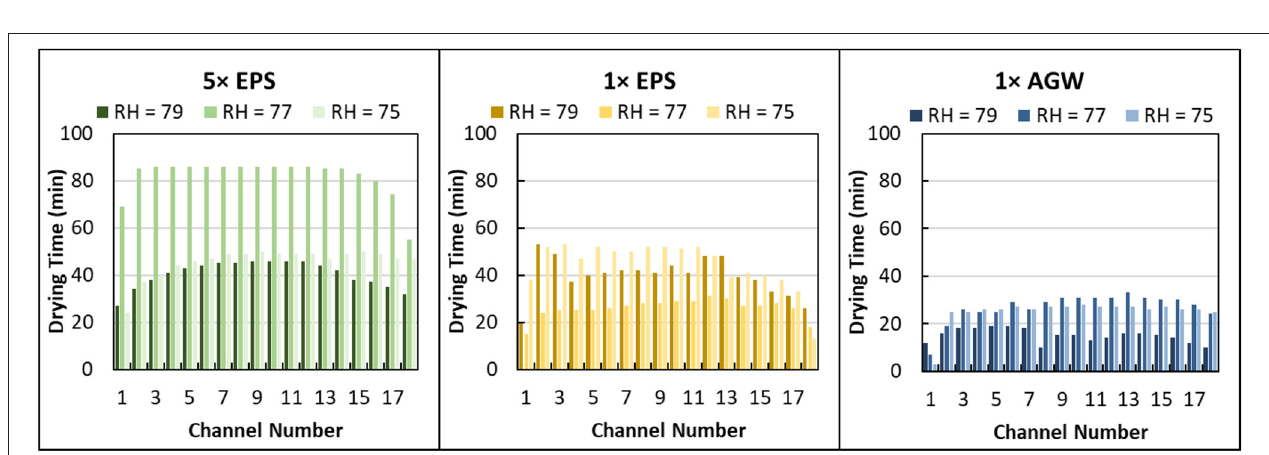
FIGURE 4 | Drying behavior of a 1 × extracellular polymeric substance (EPS) solution suspended M9 media loaded into an emulated soil micromodel geometry and held at 70-75% relative humidity (RH). (A) Tiled mages of individual replicate micromodel channels (see Figure 1B ) at the operationally-defined start of the drying experiment and 20 and 40h later. (B) Fraction of water remaining (saturation) for the same channels as in (A) vs. time. (C) RH and temperature recorded in the control chamber via USB recorder for the data shown in (A,B) . See Supplemental Information for movies of drying behavior.